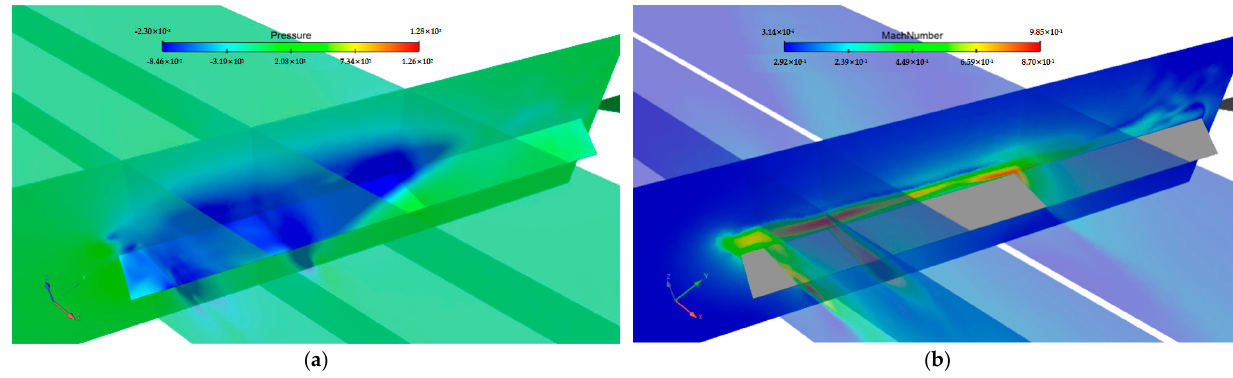
Figure 6. Slice contours of pressure ( a ) and Mach number ( b ) of the flow field.